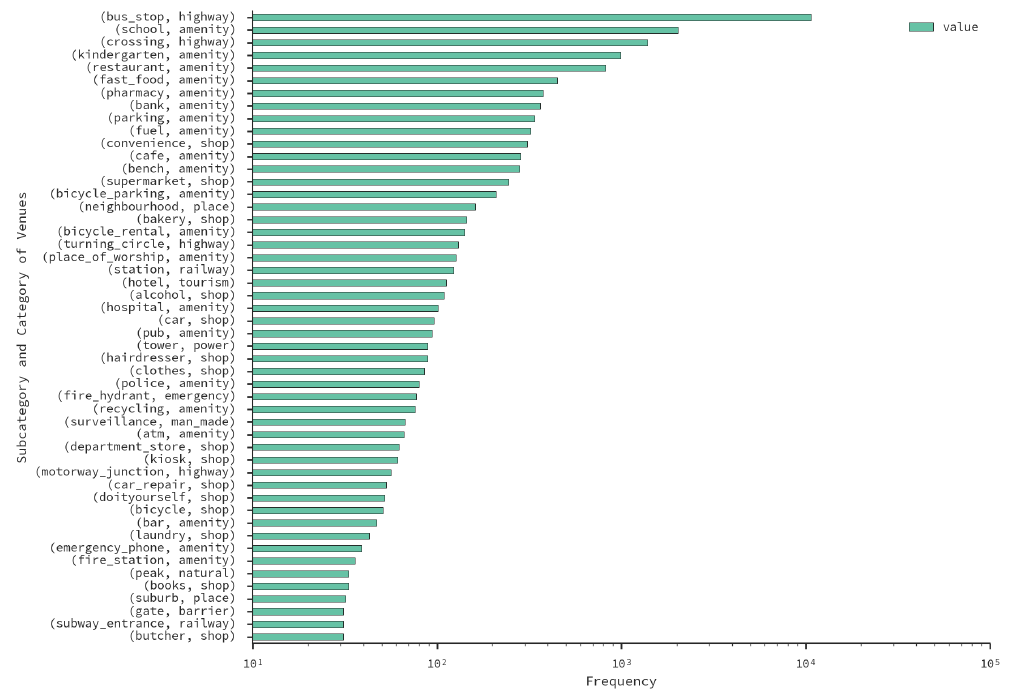
Figure 5. Number of OpenStreetMap (OSM) venues per studied sub-category in the Santiago. The labels include secondary category and primary category of each venue type.